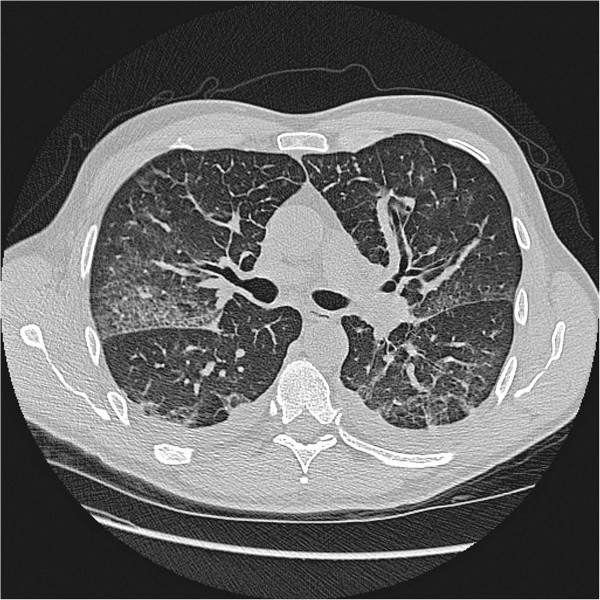
Chest high-resolution computed tomography image from a patient with Puumala hantavirus infection. Investigation was performed four days post onset of disease and shows bilateral pleural effusion and pulmonary oedema in a previously healthy non-smoking patient with pronounced clinical lung manifestations.